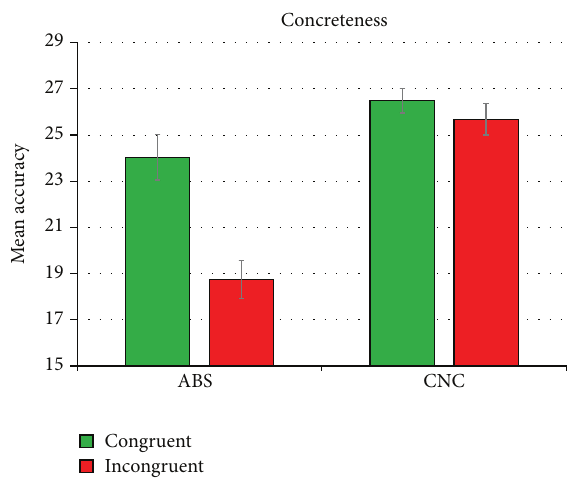
Figure 2: Mean accuracy scores for the concreteness × congruency interaction in the whole group. Error bars represent standard errors.